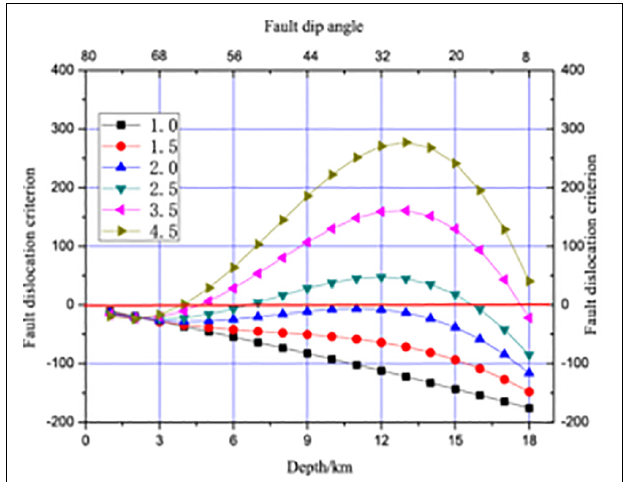
FIGURE 6 | f 1 value of Longmenshan fault zone under different side pressure